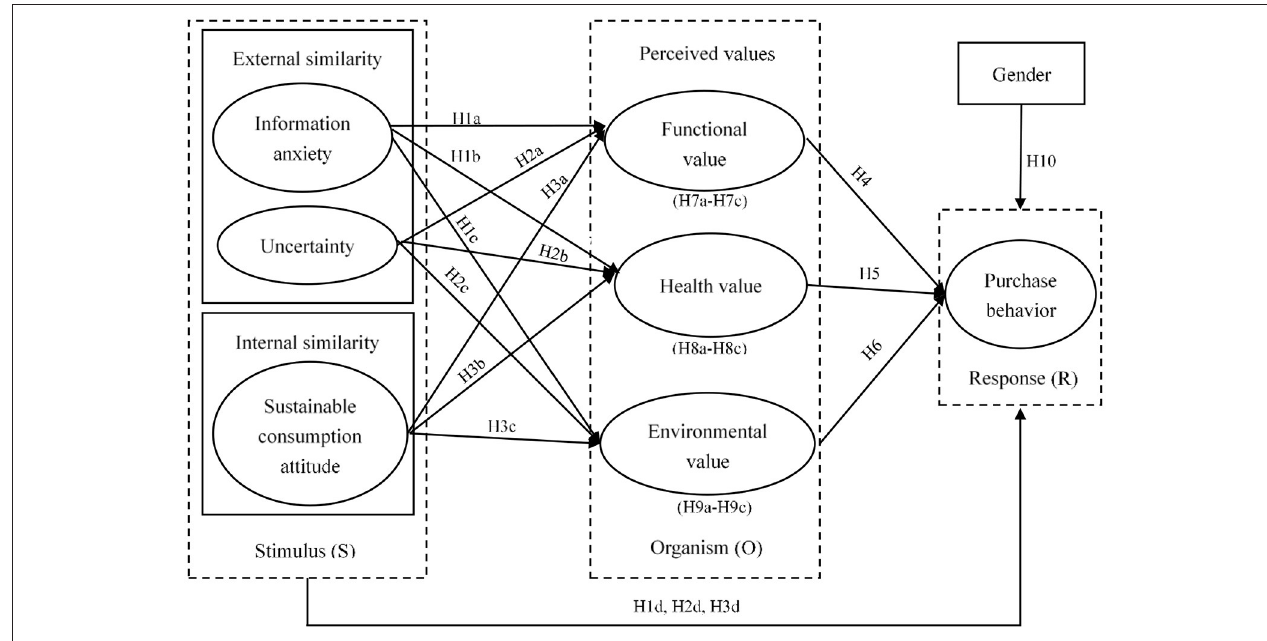
FIGURE 1 | Research